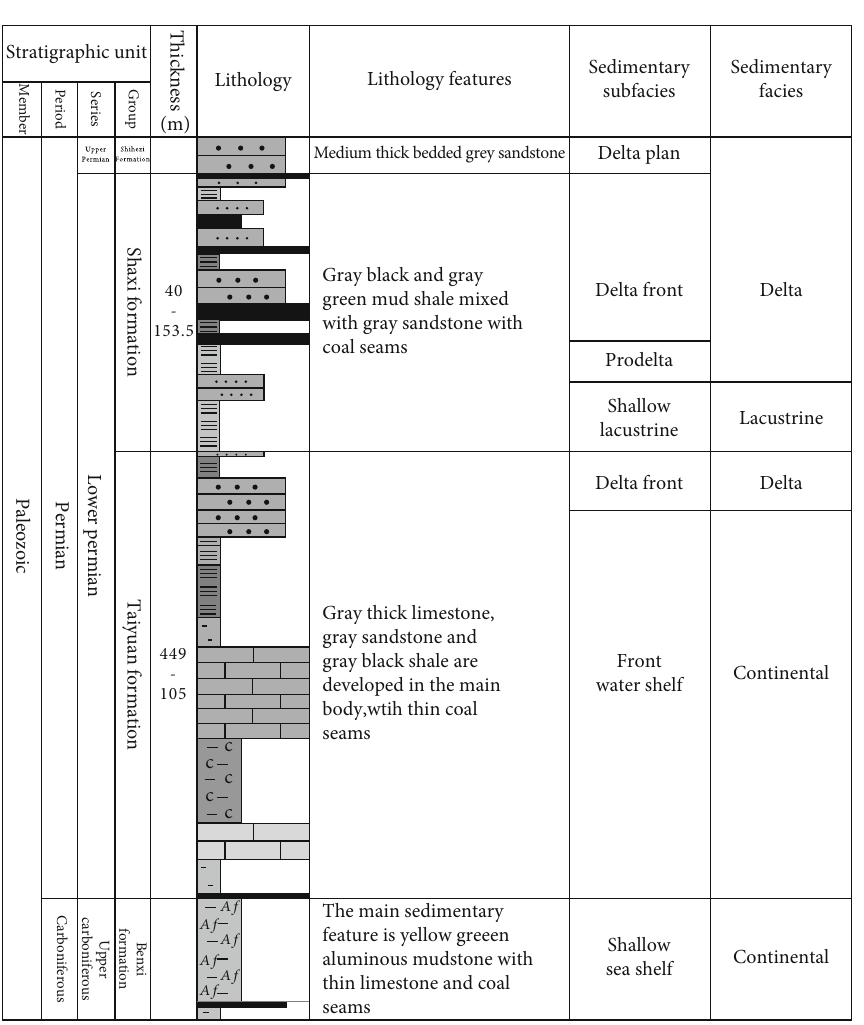
Figure 2: The C-P measured section column of the Taitou pro fi le in Shanxi